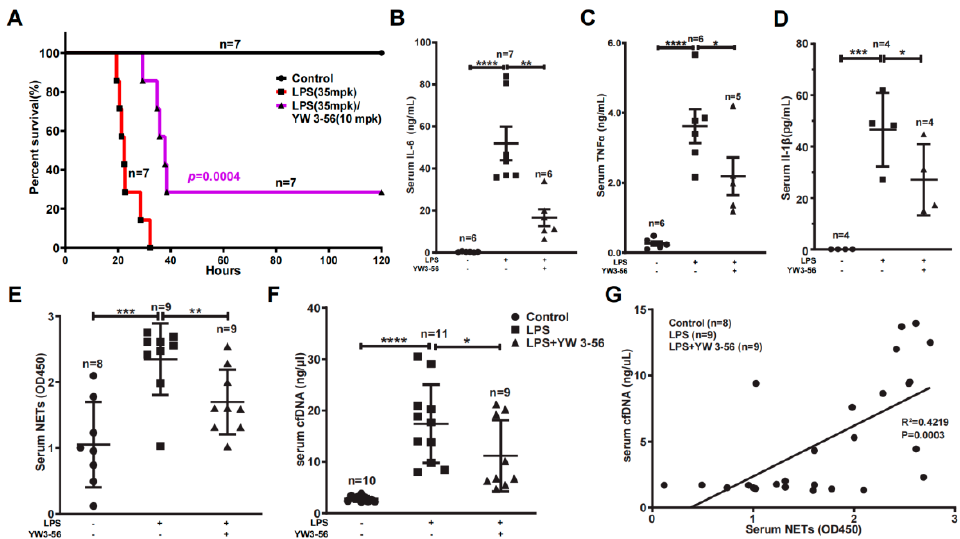
Figure 2. PAD inhibitor YW3-56 decreases endotoxic mouse death and serum NETs, cfDNA, TNF α , IL-6 and IL-1 β levels. ( A ) In lethal LPS (35 mpk) induced endotoxic stress model, treatment with YW3-56 (10 mpk) decreased LPS mediated mouse death ( n = 7 in each group). ( B – F ) Serum IL-6 levels ( n = 6, 7, 6 in each group) ( B ), TNF α levels ( n = 6, 6, 5 in each group) ( C ), IL-1 β levels ( n = 4 in each group) ( D ), NETs levels ( n = 8, 9, 9 in each group) ( E ), and cfDNA levels ( n = 10, 11, 9 in each group) ( F ) were much increased after LPS treatment, while YW3-56 treatment significantly decreased serum IL-6, TNF α , IL-1 β , NETs and cfDNA levels. ( G ) Serum cfDNA levels had a strong correlation with the serum NET levels. The Person’s correlation analysis was used in survival analysis. All data in figures were presented as mean ± SEM. * p < 0.05; ** p < 0.01; *** p < 0.001; **** p < 0.0001. IL, interleukin; TNF, tumor necrosis factor; NET, neutrophil extracellular trap; cfDNA, cell free DNA; LPS, lipopolysaccharides.